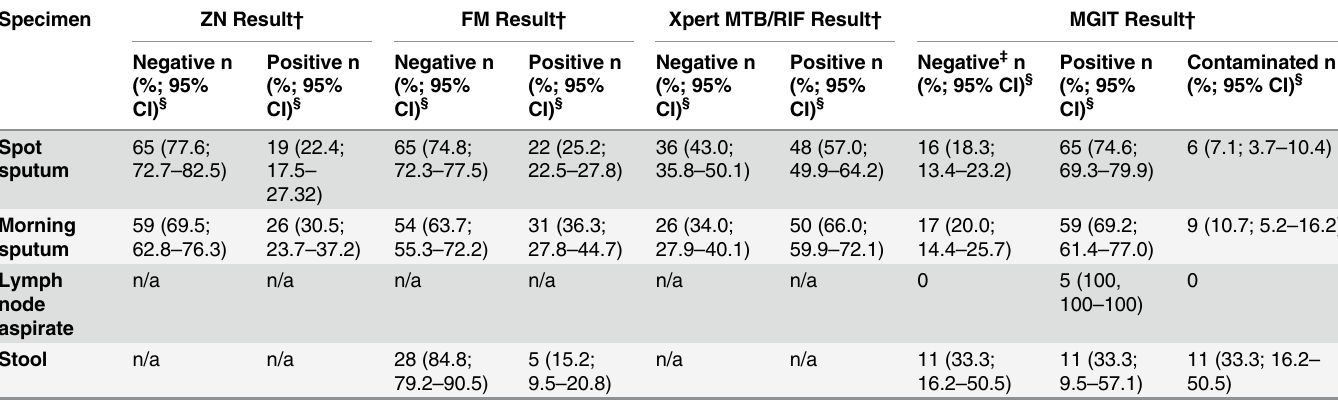
Table 2. Laboratory test results of participants diagnosed with TB, by type of test and specimen type (n = 88) * .